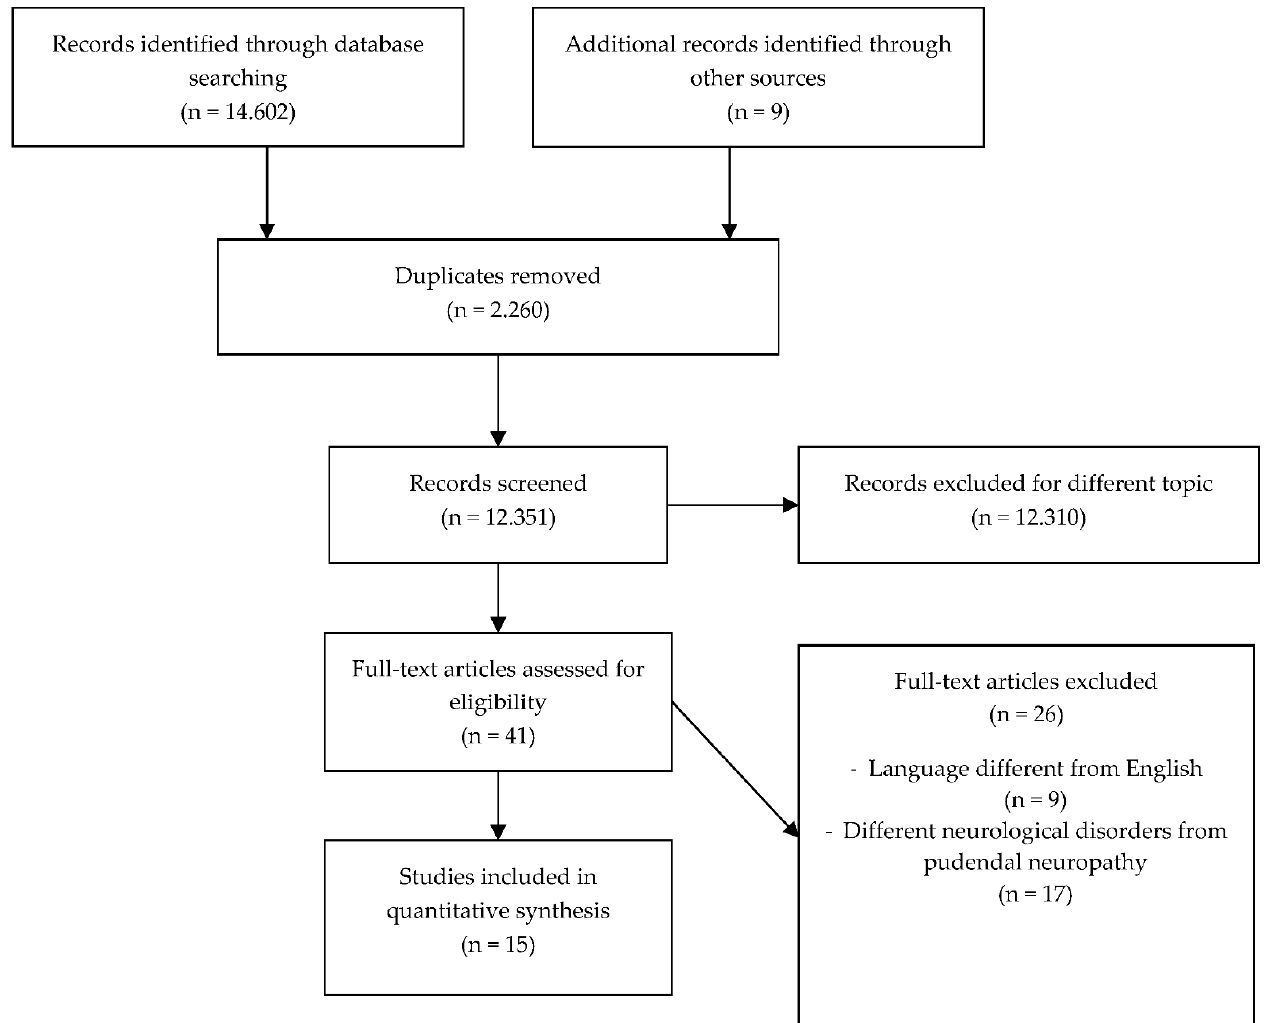
Figure 1. Flowchart of the process of literature search and extraction of studies meeting the inclusion criteria.